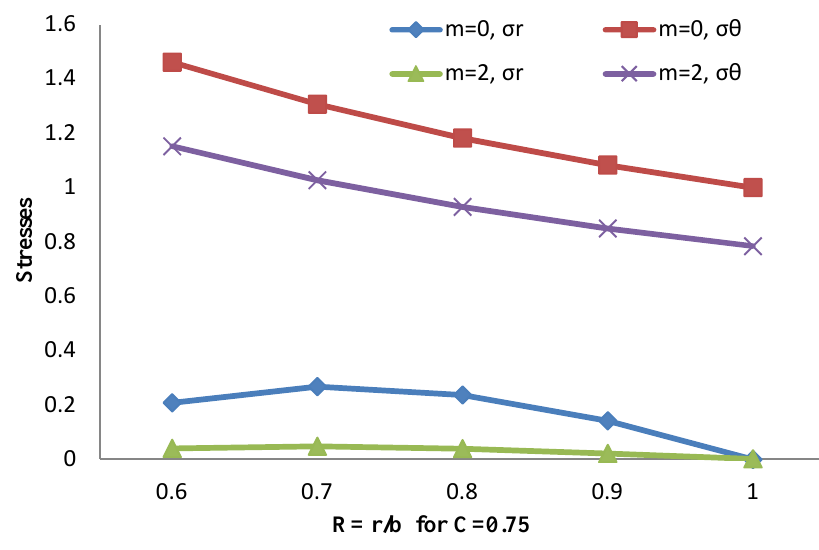
Figure5. Stress distribution with respect to radii ratio R = r/b for C =